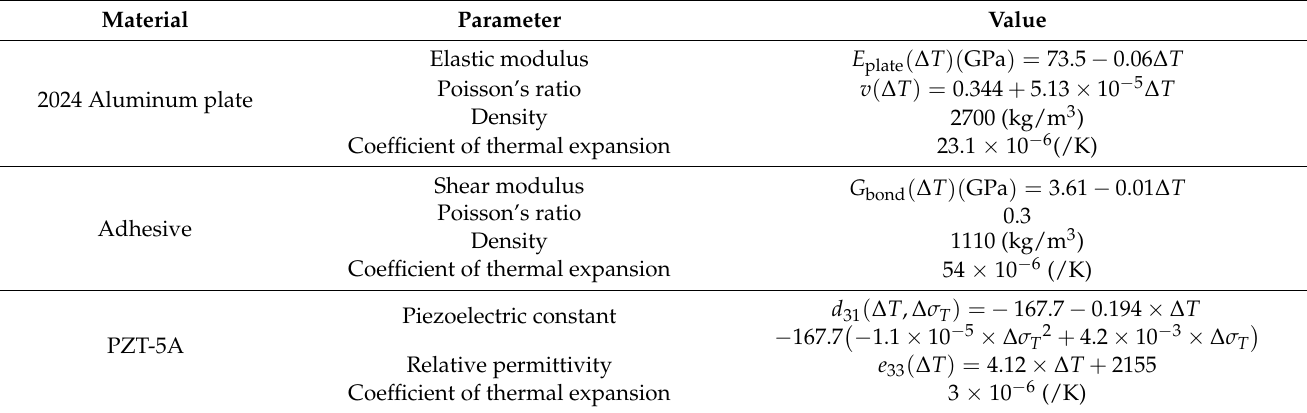
Table 3. Material properties of aluminum plate, adhesive, and PZT (PZT-5A).